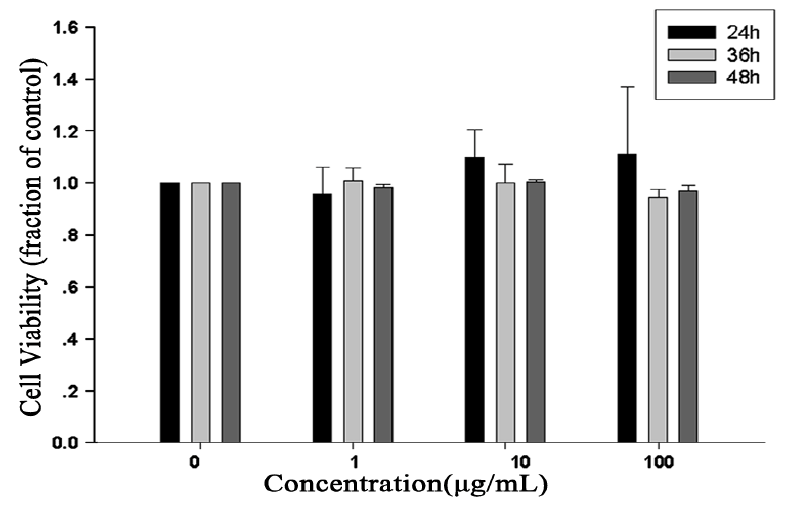
Figure 2. Effects of RTB on cell viability. RAW264.7 cells were treated with various concentrations of RTB for 24, 36 or 48 h, respectively. Cell viability was determined by alamarBlue assay, as described in Materials and Methods. Cell viability in absence of RTB treatment was taken as 100%. The results were expressed as the mean ± SD of three independent